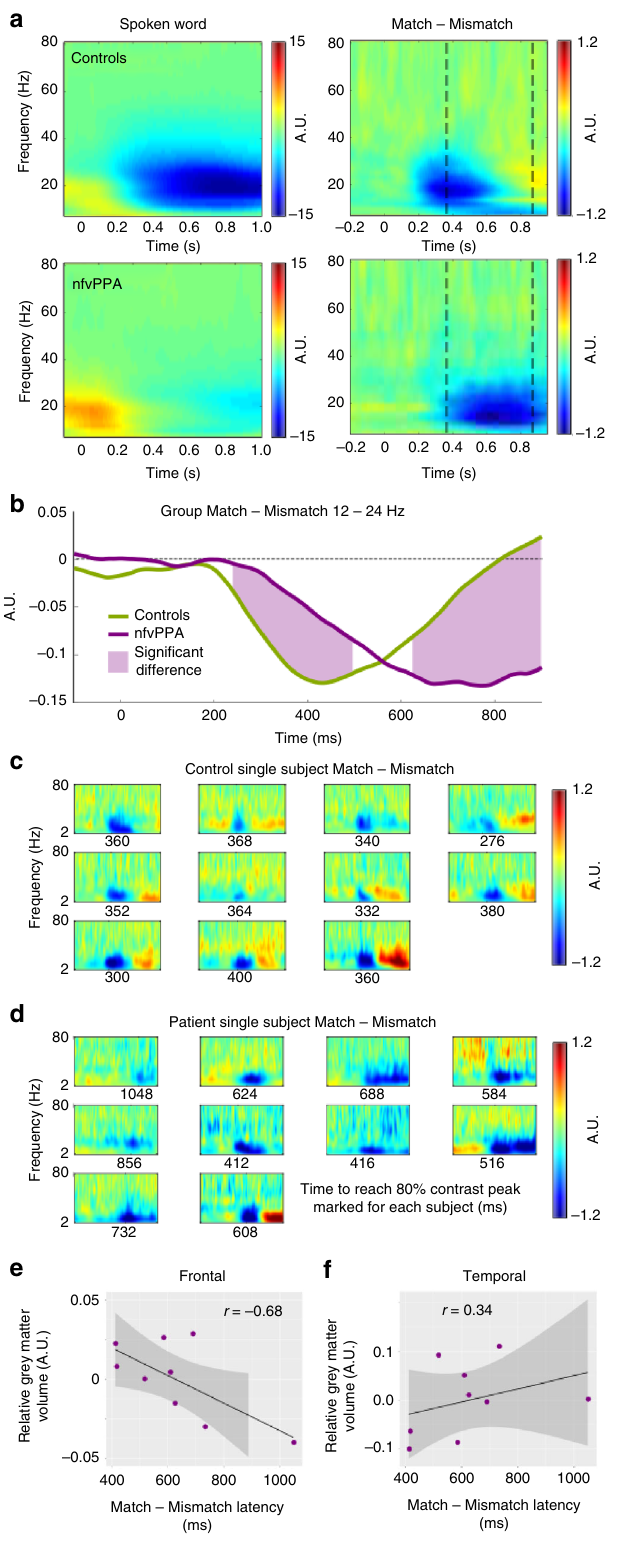
Fig. 7 Analysis of induced responses after the spoken word. a Total induced power after spoken word onset and main effect of cue congruency by group. b Overall induced power difference between Match and Mismatch conditions in the alpha/beta overlap range. c Single subject time – frequency pro fi les for each control. The time taken to reach 80% of the peak power contrast between Match and Mismatch trials is indicated for each individual by the number below the corresponding abscissa. d Single subject time – frequency pro fi les for each patient. e Signi fi cant negative correlation between frontal grey matter volume (adjusted for age and total-intracranial volume at the co-ordinates in Fig. 5c) and the time taken to express a congruency contrast ( d ). The grey shaded area indicates the 95% con fi dence band for the regression line, marked in black. f No signi fi